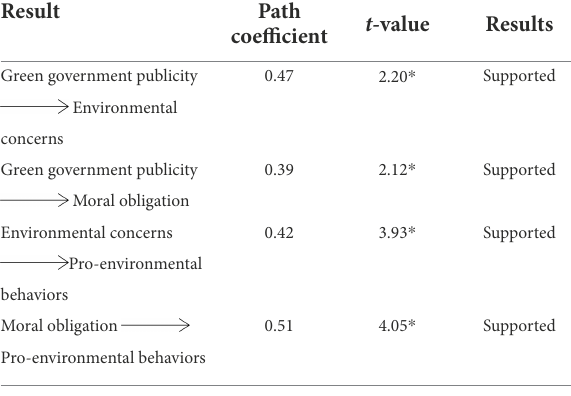
TABLE 3 Results of hypotheses and model statistics.